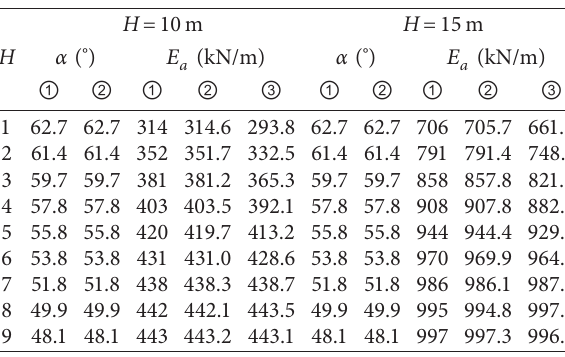
Table 1: Calculated values of limit rupture angle and active earth pressure under different l / H